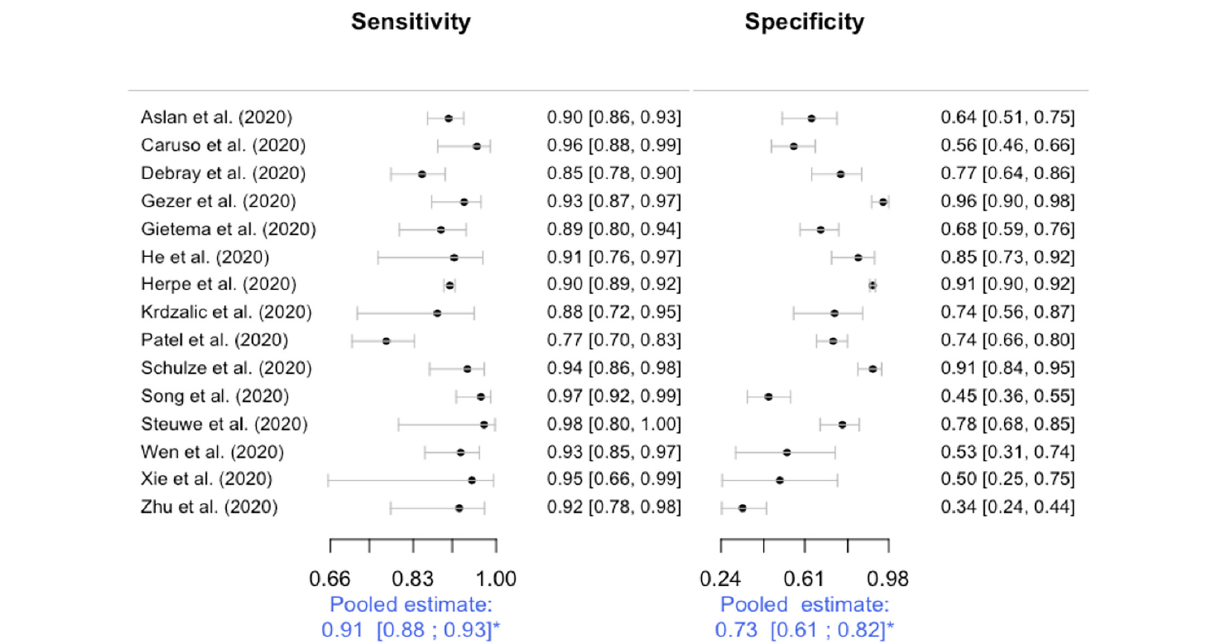
FIGURE 2 | Forest plots for sensitivity and specificity. Studies are sorted alphabetically. *Estimated pooled sensitivity and specificity with their 95% confidence intervals from bivariate methods using a random effects model. As no statistical method is currently available for heterogeneity assessment in diagnostic metanalysis with bivariate methods, heterogeneity was assessed qualitatively and considered low for sensitivity and high for specificity. Although high, heterogeneity for specificity estimates was explained by differences between studies and thus considered not serious (see quality of evidence in the results section). Sensitivity analysis excluding studies with concerns regarding flawed reference standard did not change displayed